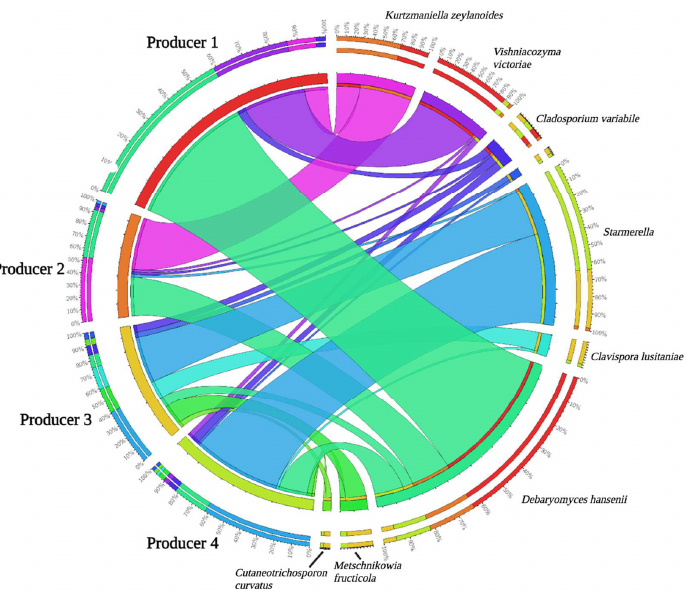
Figure 2. Circular ideogram showing the fungal distribution (>1% of the relative frequency in at least 2 samples) among the Queijo Serra da Estrela PDO cheese PDO cheese samples herein analyzed. Amplicon Sequence Variants (ASVs) and samples are connected with ribbons, whose thickness is proportional to the abundance of ASVs in the connected samples. The outer circle displays the proportion of each ASV in each producer and vice versa.